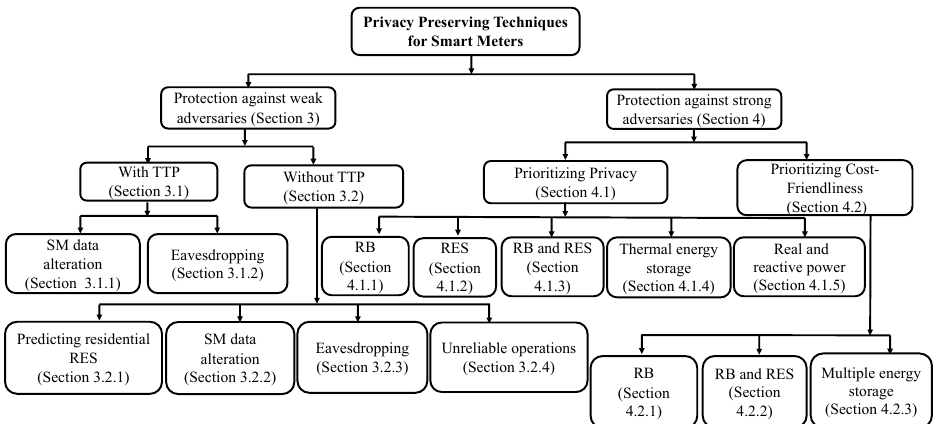
Figure 4. Taxonomy of smart meter privacy-preservation approaches and techniques surveyed and reviewed in this